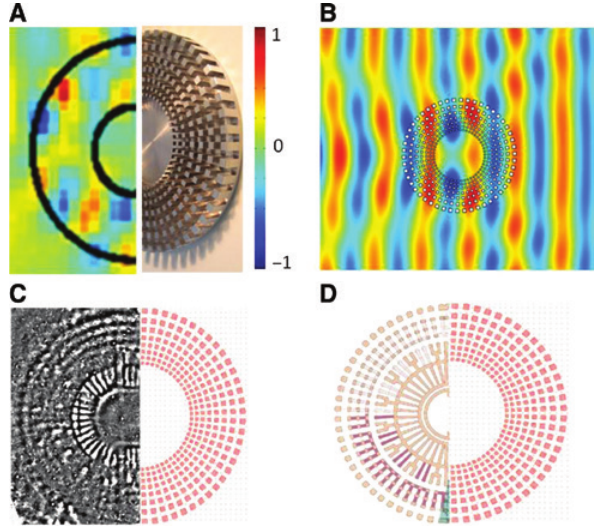
Fine line curves represent the 95% of interval of confi- dence. These curves are very close to the average solid red or green curve, indicating a good quality of measurement.